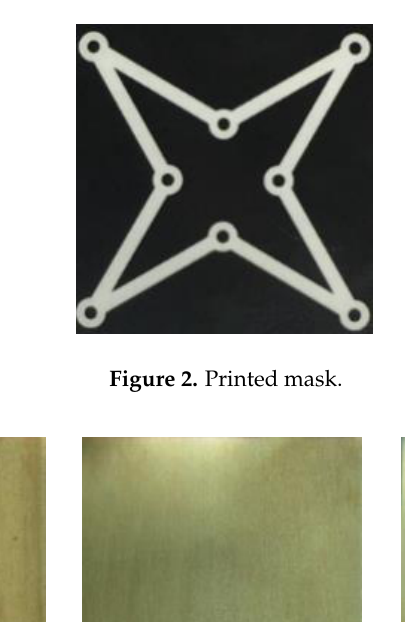
Figure 2. Printed mask.